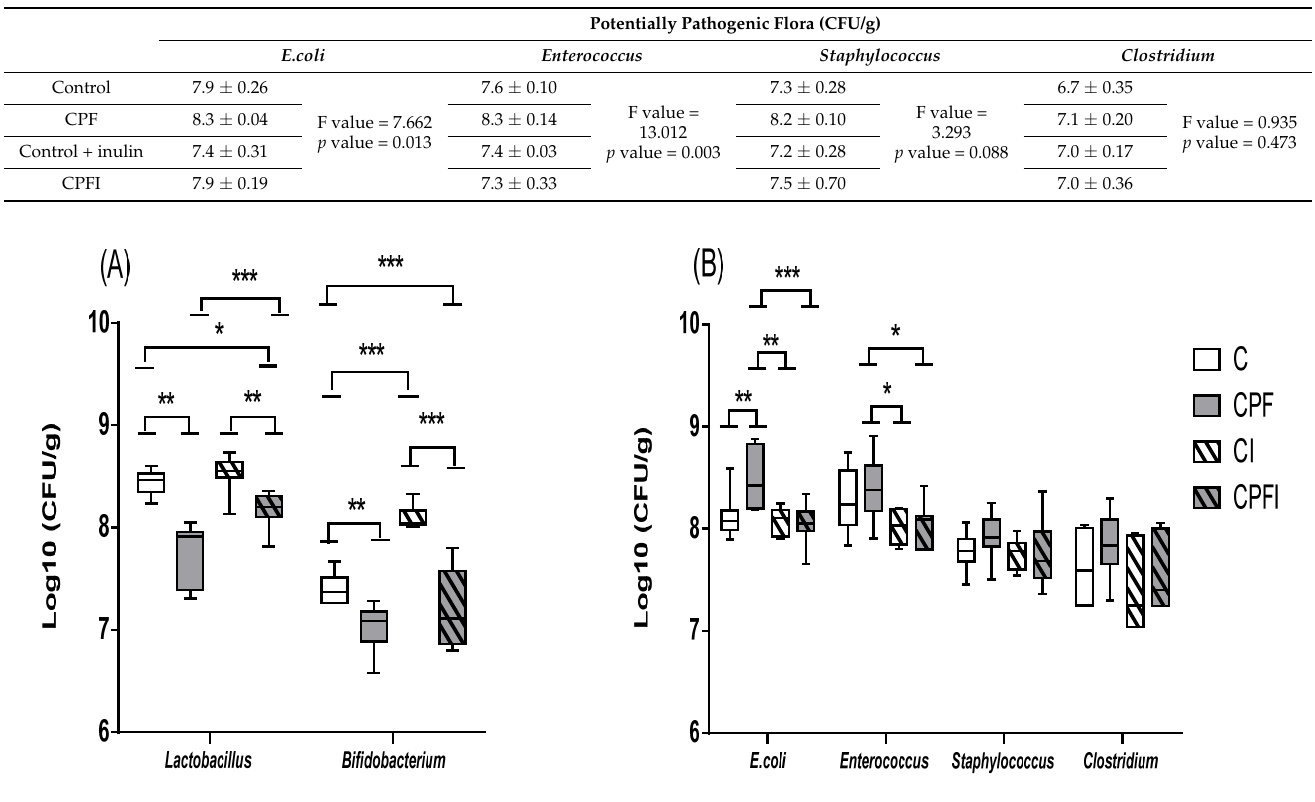
Figure 4. Effects of perigestational exposure to CPF and inulin on beneficial flora ( A ) and on poten- tially pathogenic flora ( B ) of female offspring. Values are expressed as mean ± SEM ( n = 7–10) using analysis of variance (ANOVA) and Tukey’s test. Significance * p < 0.05; ** p < 0.01, *** p < 0.001. C: Control; CPF: Chlorpyrifos; CI: Control inulin; CPFI: Chlorpyrifos + inulin.